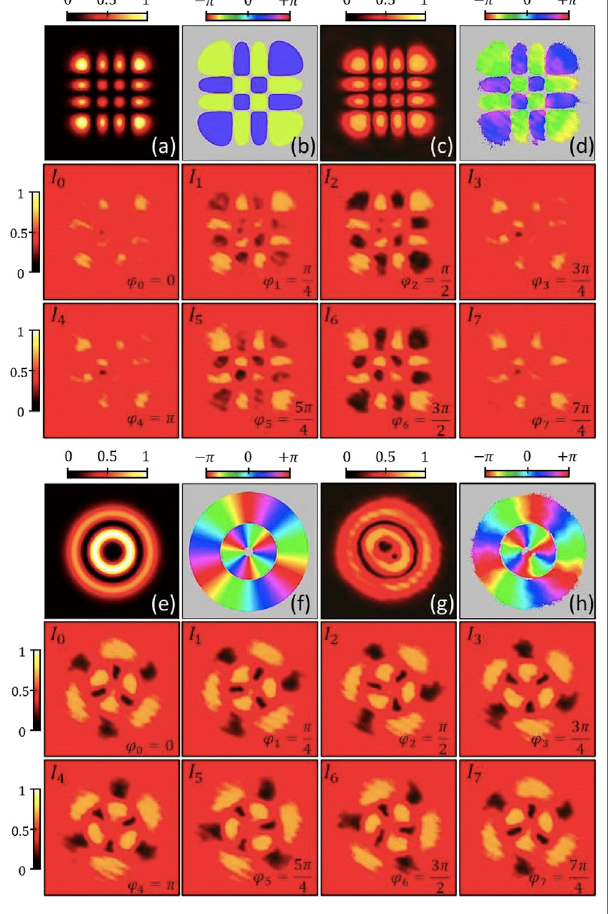
The angle of the polarizer P1 was adjusted to achieve the best contrast before capturing all the sequence of interferograms.